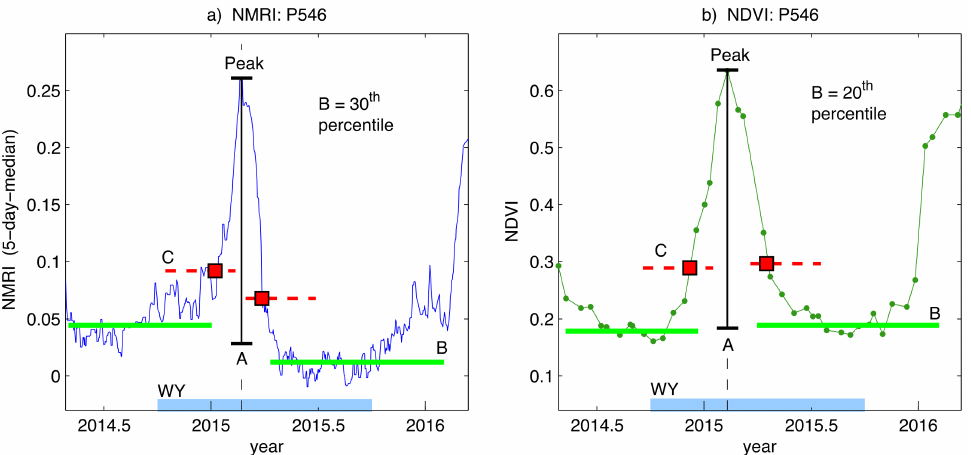
Figure 3. Example analysis used to retrieve the amplitude of the seasonal peak, the Start of Season (SOS) and End of Season (EOS) day of year. The seasonal peak is within the Water Year (thick light blue line on x -axis labeled WY). The baseline (green line B) on each side of the peak is the level of pre/post-growth vegetation. The amplitude (black line A) is the difference between the peak and the average baseline pre/post-growth. The red dotted lines are the 25% cut off levels with respect to the pre/post-growth baselines, and they intersect the main seasonal growth cycle at the SOS and EOS day of year (red squares). ( a ) the daily five-day median NMRI uses the 30th percentile to define the baseline; and, ( b ) the interpolated bi-weekly NDVI uses the 20th